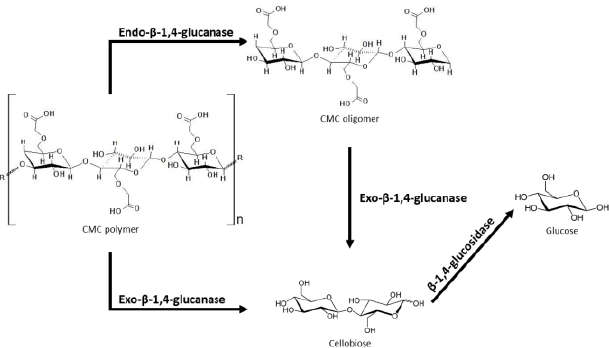
Figure 2. CMC biodegradation and enzymes involved in the attack of CMC linkages [31].